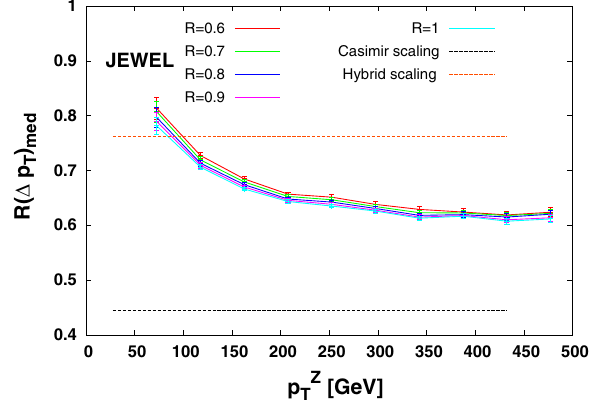
Fig. 8 Scaling for large jet parameter values of the scaling just for . R (Δ p T ) T